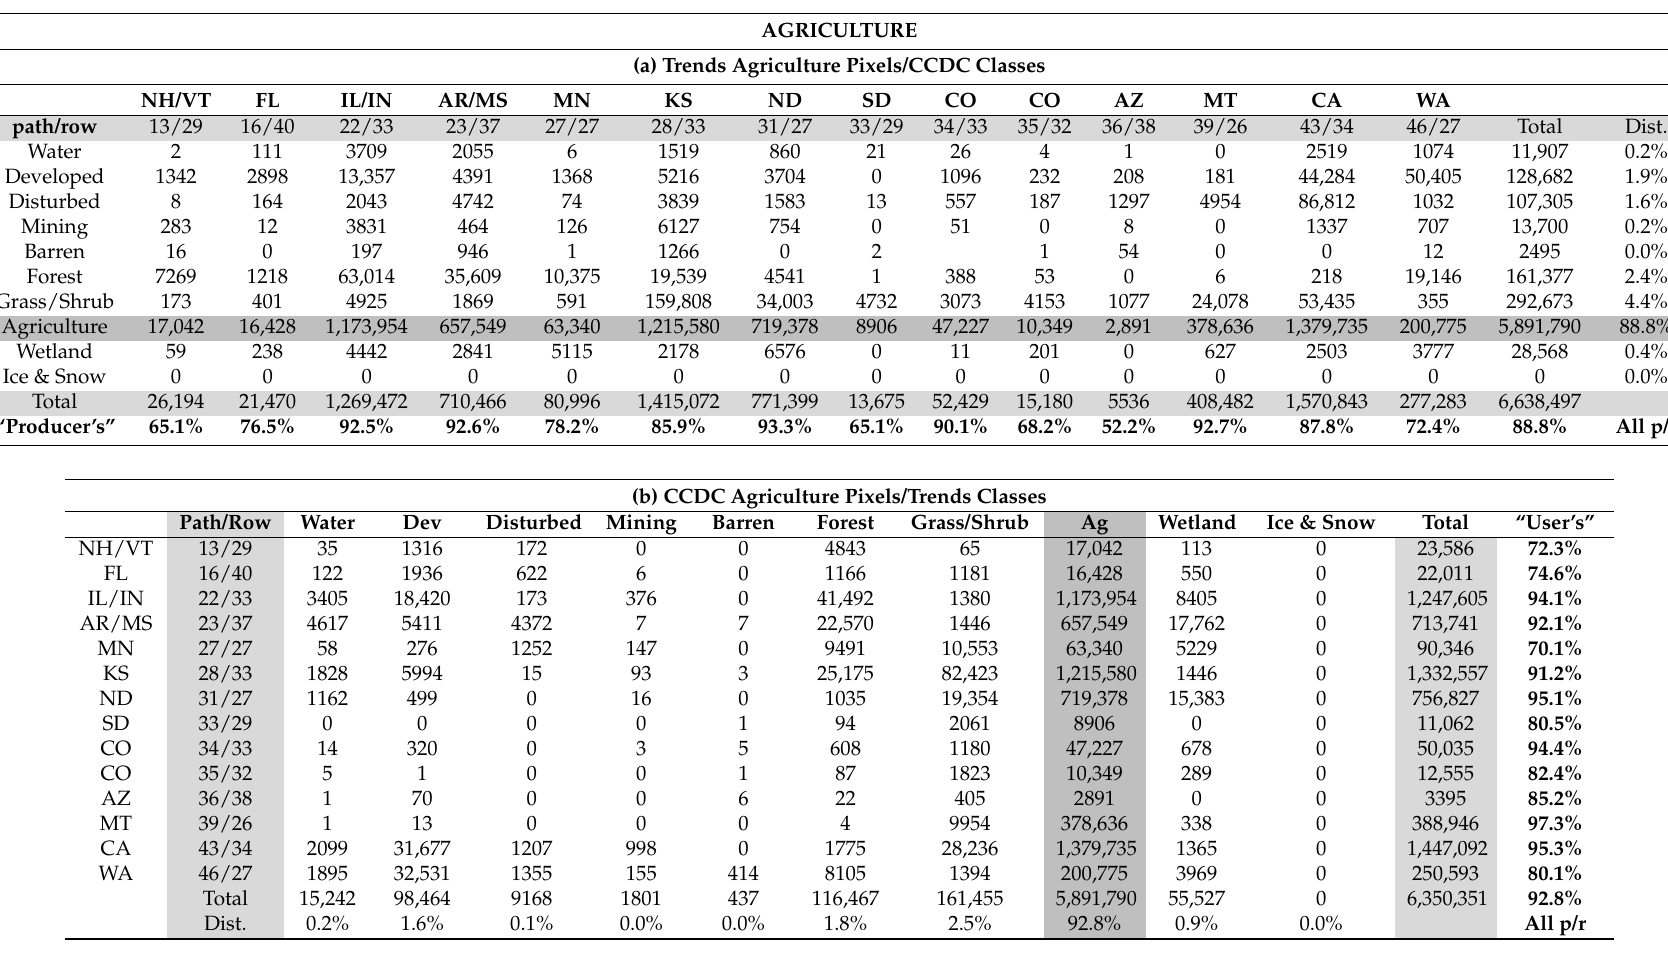
Table 6. (a) LC Trends circa 2000 Agriculture pixels distributed across CCDC classes for each path/row location and (b) CCDC circa 2000 Agriculture pixels distributed across LC Trends classes for each path/row location. AR = Arkansas; AZ = Arizona; CA = California; CO = Colorado; FL = Florida; IL = Illinois; IN = Indiana; KS = Kansas; MN = Minnesota; MS = Mississippi; MO = Montana; ND = North Dakota; NH = New Hampshire; SD = South Dakota; VT = Vermont; WA =